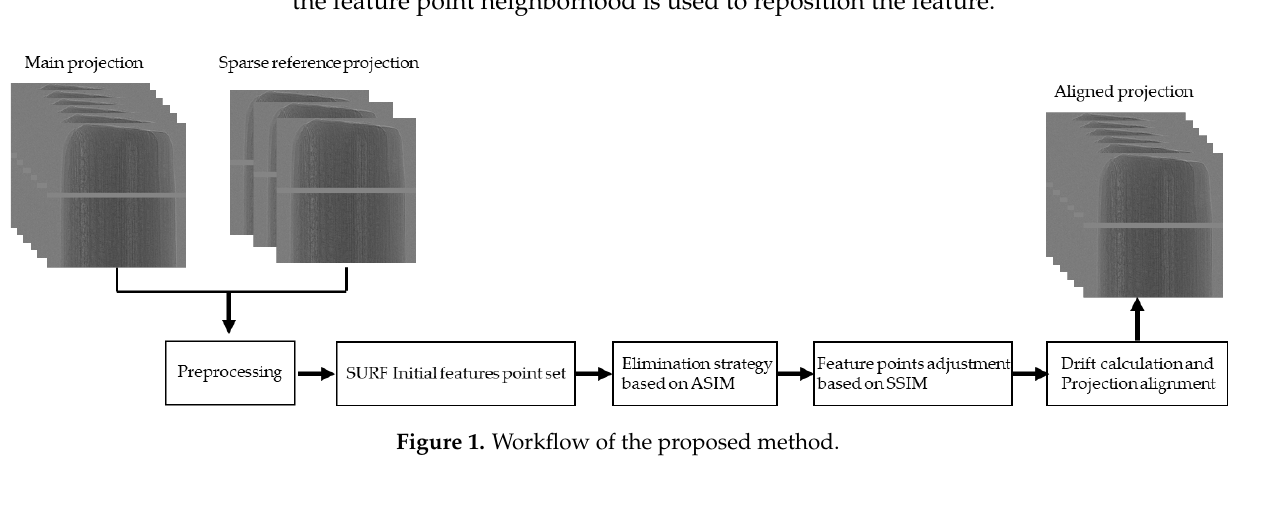
Figure 1. Workflow of the proposed method.